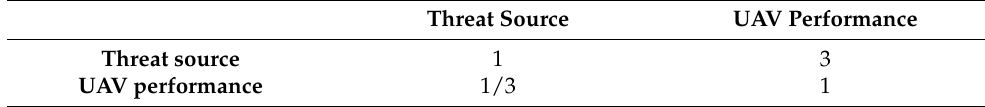
Table 14. Judgmental matrixes of AHP criteria hierarchy of recovery point.